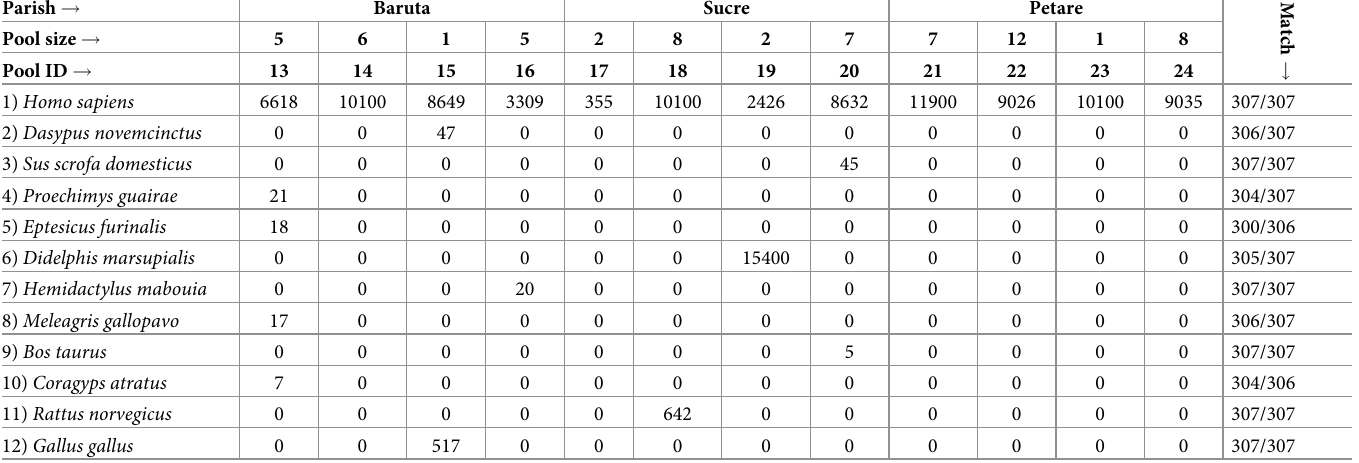
Table 3. Vertebrate sources of cytb DNA identified in P . geniculatus bloodmeals for the MDC collection period 2013–2016. Dissection pools 13–24 are organized in columns based on the parish from which contributing samples were obtained. Pool sizes (i.e., the number of samples contributing to each pool) range from 1–12. Verte- brate species with cytb sequences matching pool sequences at � 90% similarity are listed in rows numbered 1–12. Corresponding read support values are provided at right prior to the ‘Match’ column indicating the fraction of nucleotides matching between pool sequences and the reference (excluding primer binding sites). Parish